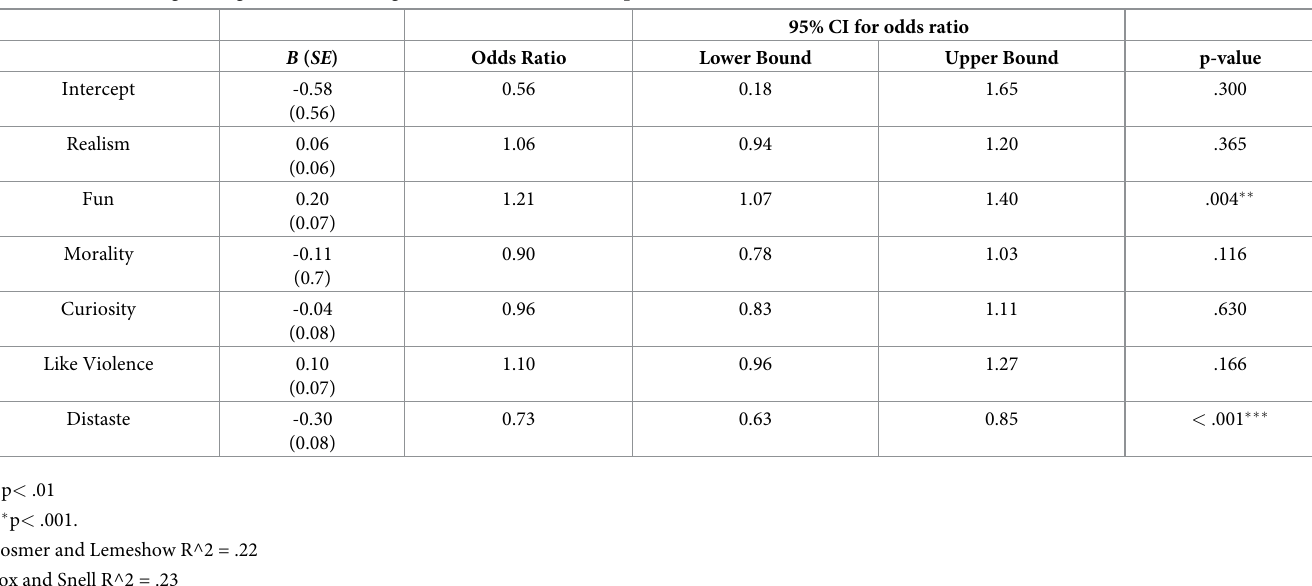
Table 10. Results of logistic regression: Predicting violent choices with self-reported